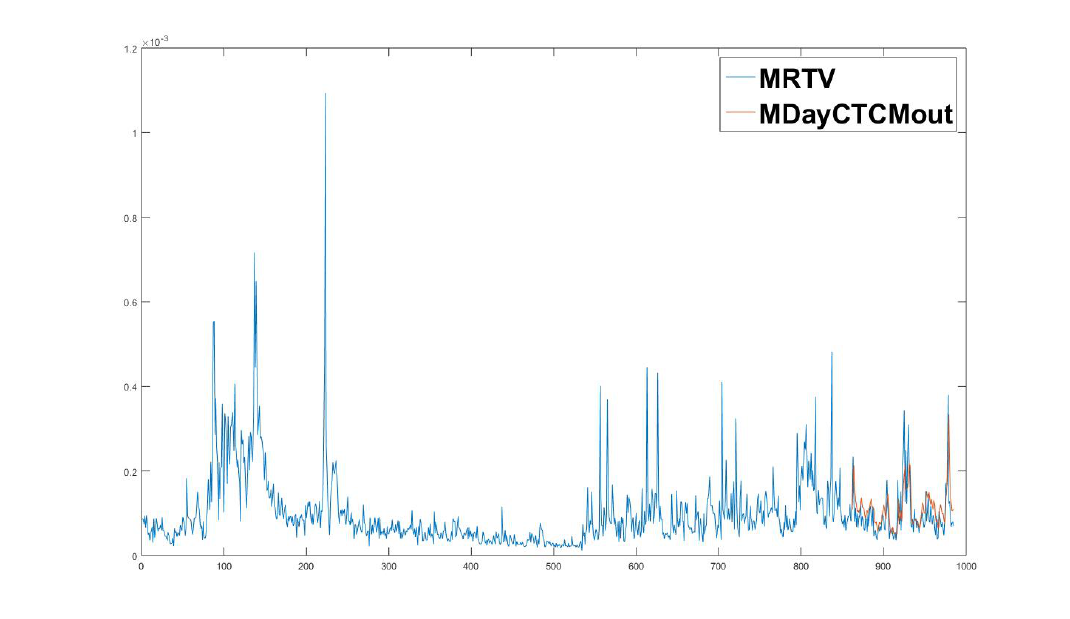
Figure 11. Model CTCM-RTV-D Forecast for M(DCE). The horizontal line is the timeline, and the perpendicular line is the volatility estimator. The forecasted period is the last 124 days. The actual values are represented by the blue line, while the forecasted values are represented by the orange line. The forecasted values are a bit higher than the actual values except for the values around the Day 920.